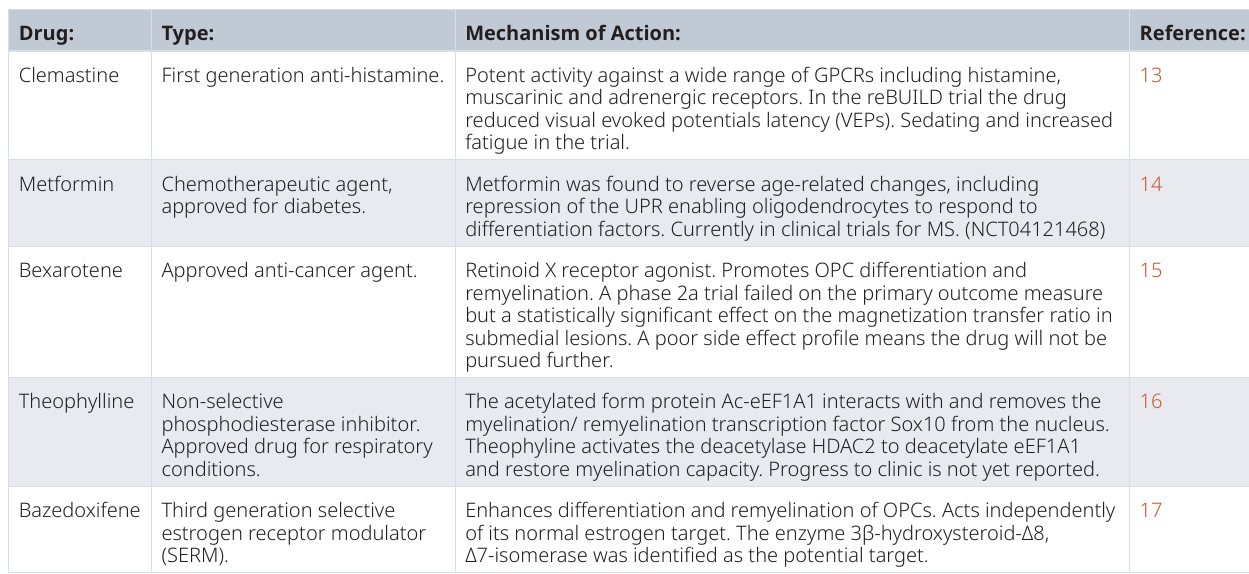
Table 1. Summary of agents showing some promise in preserving myelin or as